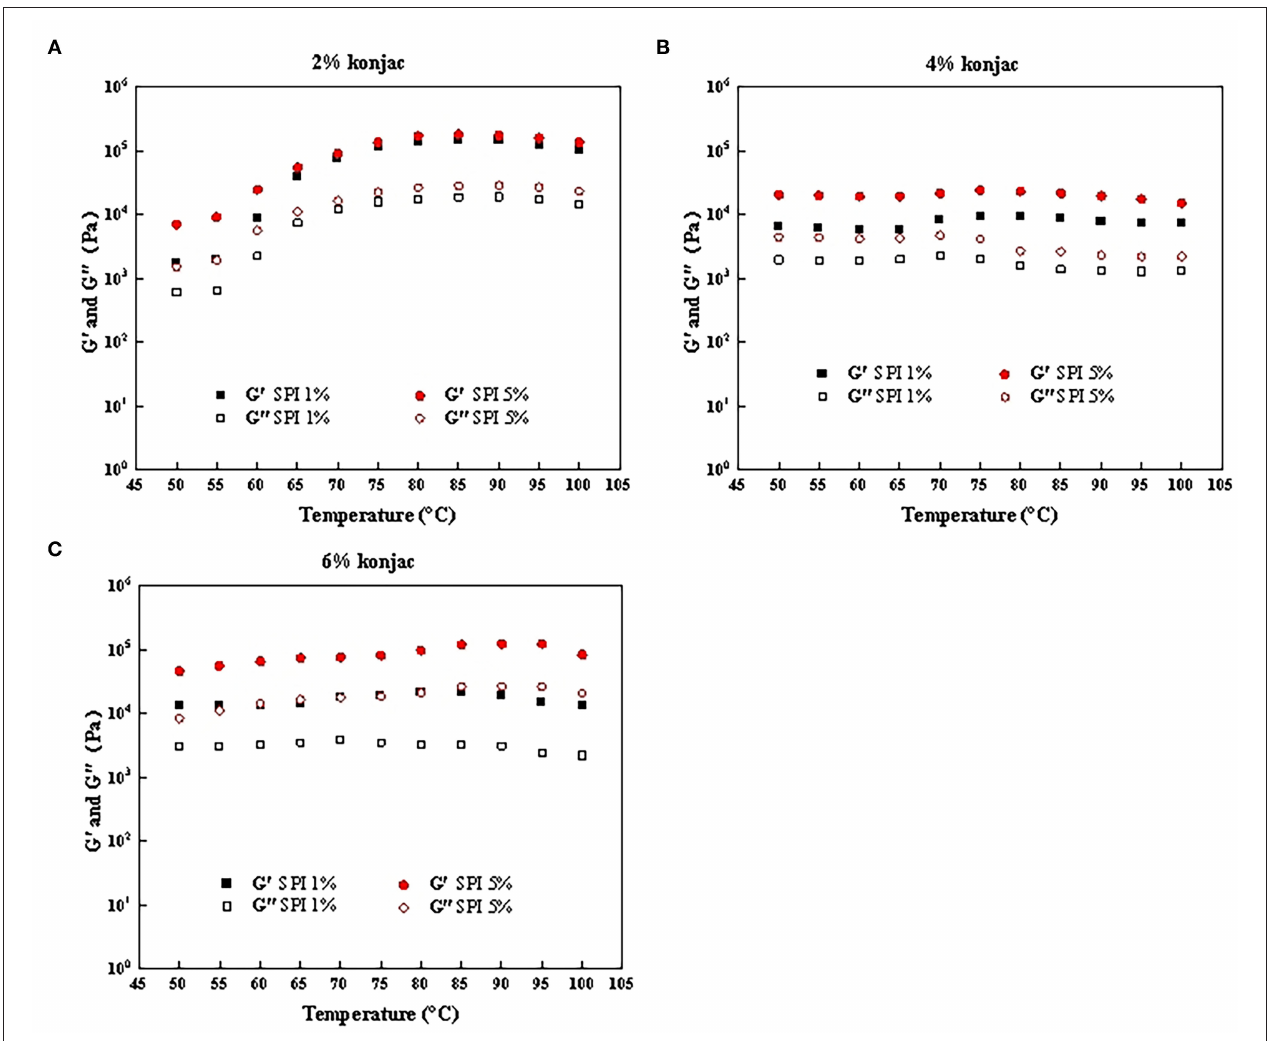
FIGURE 7 | The temperature scanning results of samples with different protein content and konjac content. (A) S1K1, S5K1; (B) S1K4, S5K4; (C) S1K6, S5K6.